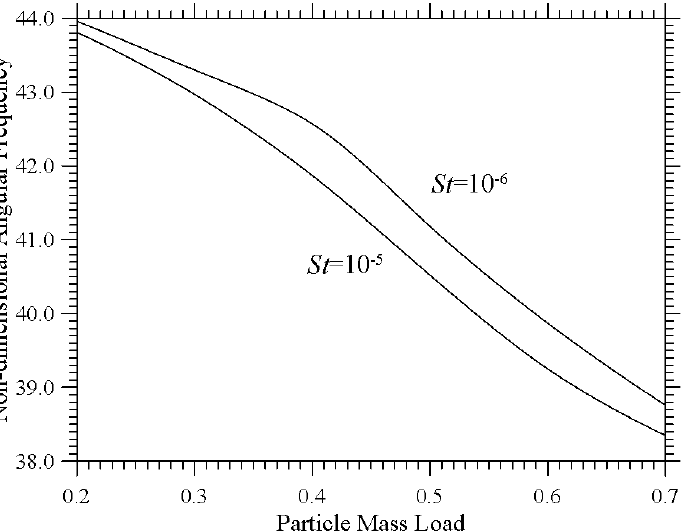
Figure 6. HTW angular frequency as a function of the mass load for different values of the particle Stokes number.